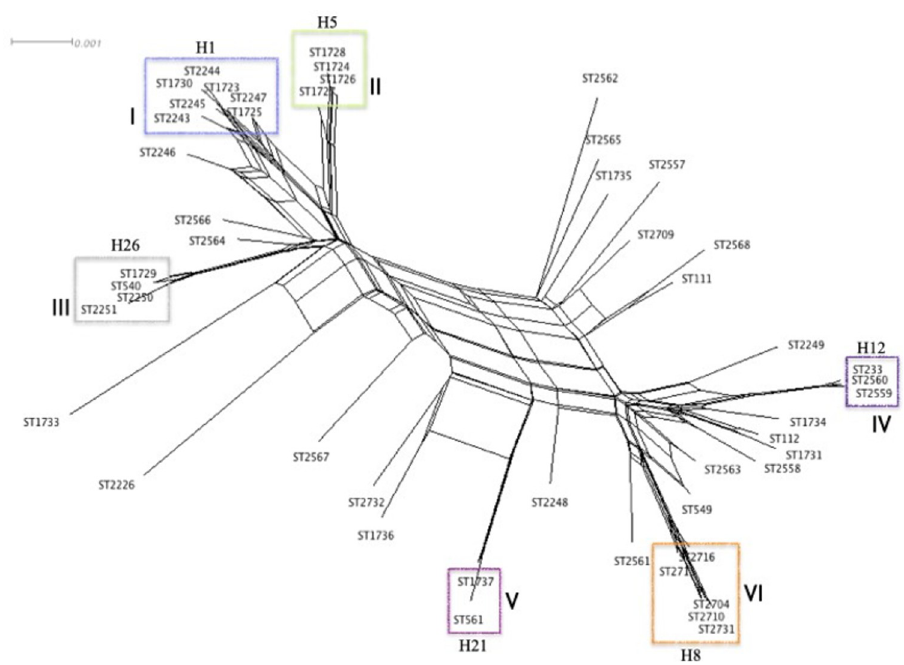
Fig 3. Neighbor-net graph based on the MLST genotyping of the P . aeruginosa strains. P . aeruginosa isolates (48 STs). Rectangular boxes represent the high probability of extensive homologous recombination. The PHI test detected statistically significant evidence of recombination ( p = 0.0). Clonal complexes (CC) formed are highlighted in rectangles and described as (I, II, III, IV, V, and VI). The mexR-nalC-nalD haplotype of each CC is shown.